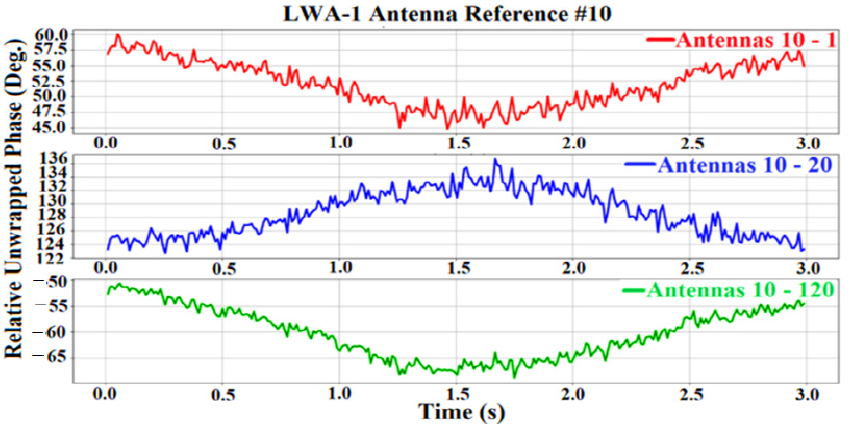
Figure 6. The plot displays an example of the relative unwrapped phases versus time in 3 s for LWA − 1.